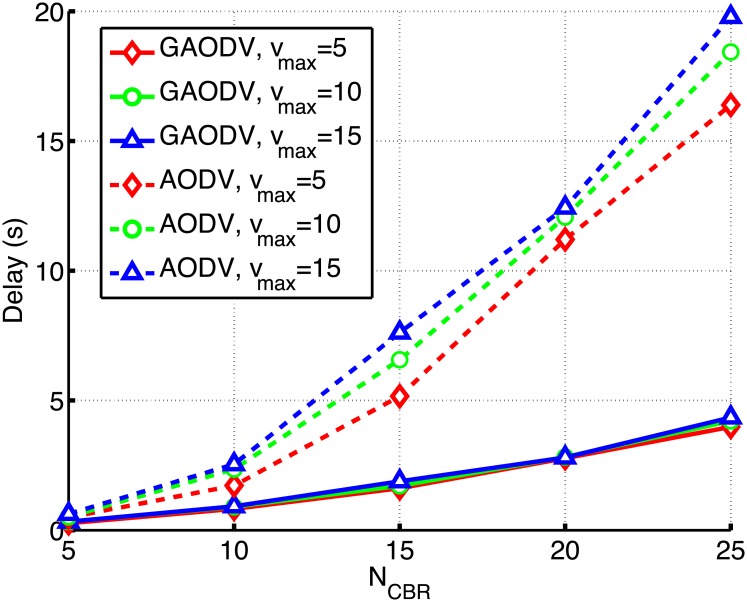
End-to-end delay for the change of NCBR and vmax.